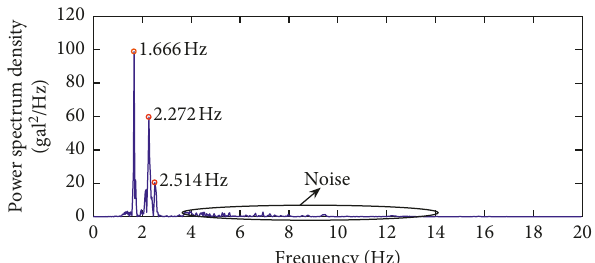
Figure 16: Spectrum diagram of the signal after EEMD-Wavelet denoising.